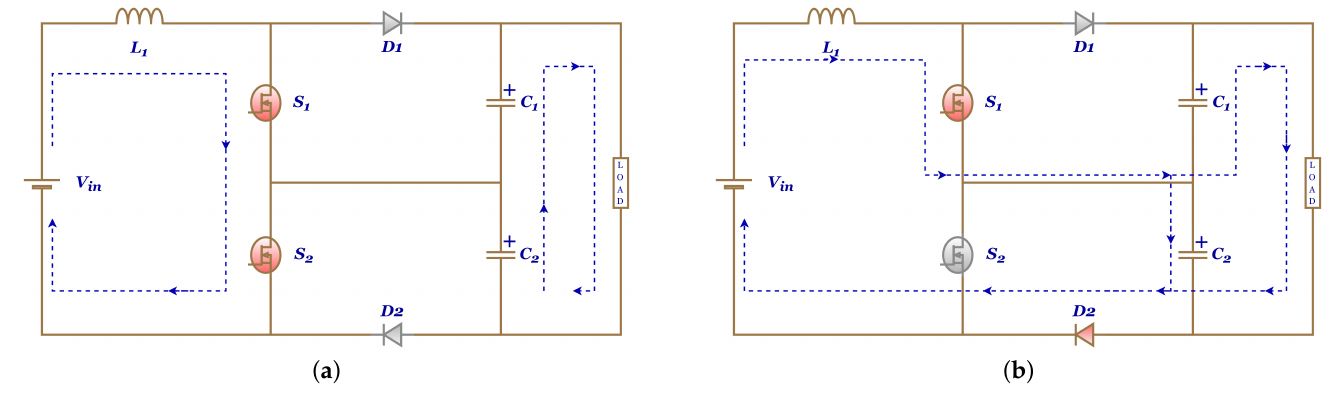
Figure 8. TLBC operation: ( a ) S 1 and S 2 closed, and ( b ) S 1